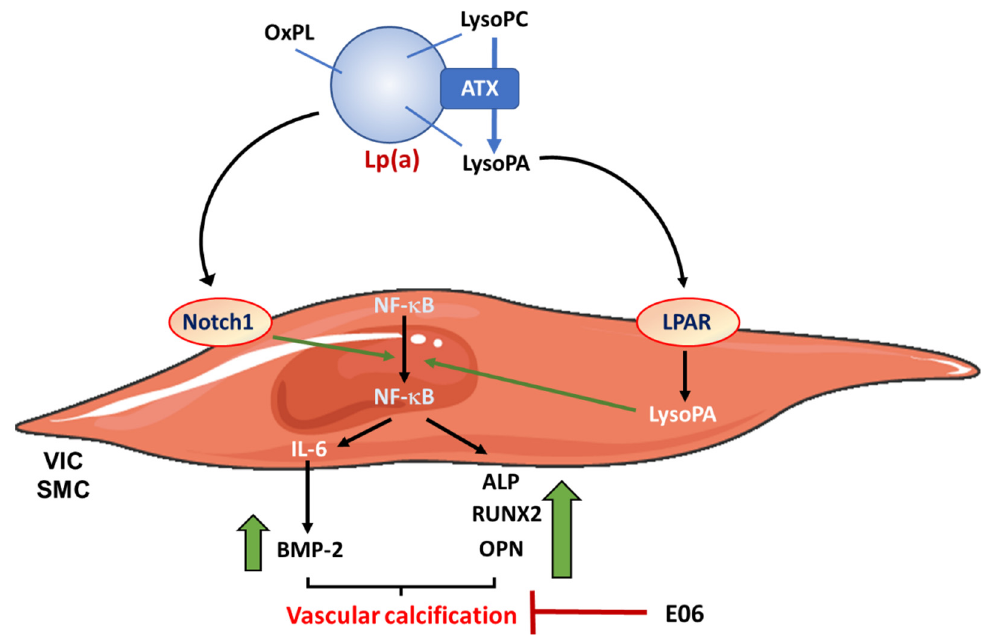
Figure 1. Lp(a) in vascular calcification: mechanisms of actions. Lp(a) is a lipoprotein transporting oxidized phospholipids (OxPL), as well as autotaxin (ATX), a lysophospholipase D that converts lysophosphatidylcholine (LysoPC) from OxPL into lysophosphatidic acid (LysoPA). Lp(a) increases cell mineralization, as well as the expression of pro-calcific proteins, by a mechanism involving the activation of the Notch1 signaling pathway, which, in turn, allows nuclear translocation of the nuclear factor- κ B (NF- κ B). This results in the induction of IL-6 expression, increasing BMP-2 concentrations, as well as the induction of the expression of RUNX2, osteopontin (OPN) and ALP. LysoPA also increases NF- κ B nuclear translocation. These effects are blocked by the presence of E06, a natural monoclonal antibody against OxPL. LPAR: lysophosphatidic acid receptor. Mechanistically speaking, PCSK9 mRNA and secreted protein increased in VICs ex ‐ posed to a pro ‐ osteogenic medium [75]. Human and rat SMC overexpressing PCSK9 had more calcium and ALP, and expressed more pro ‐ calcifying markers and lower anti ‐ calci ‐